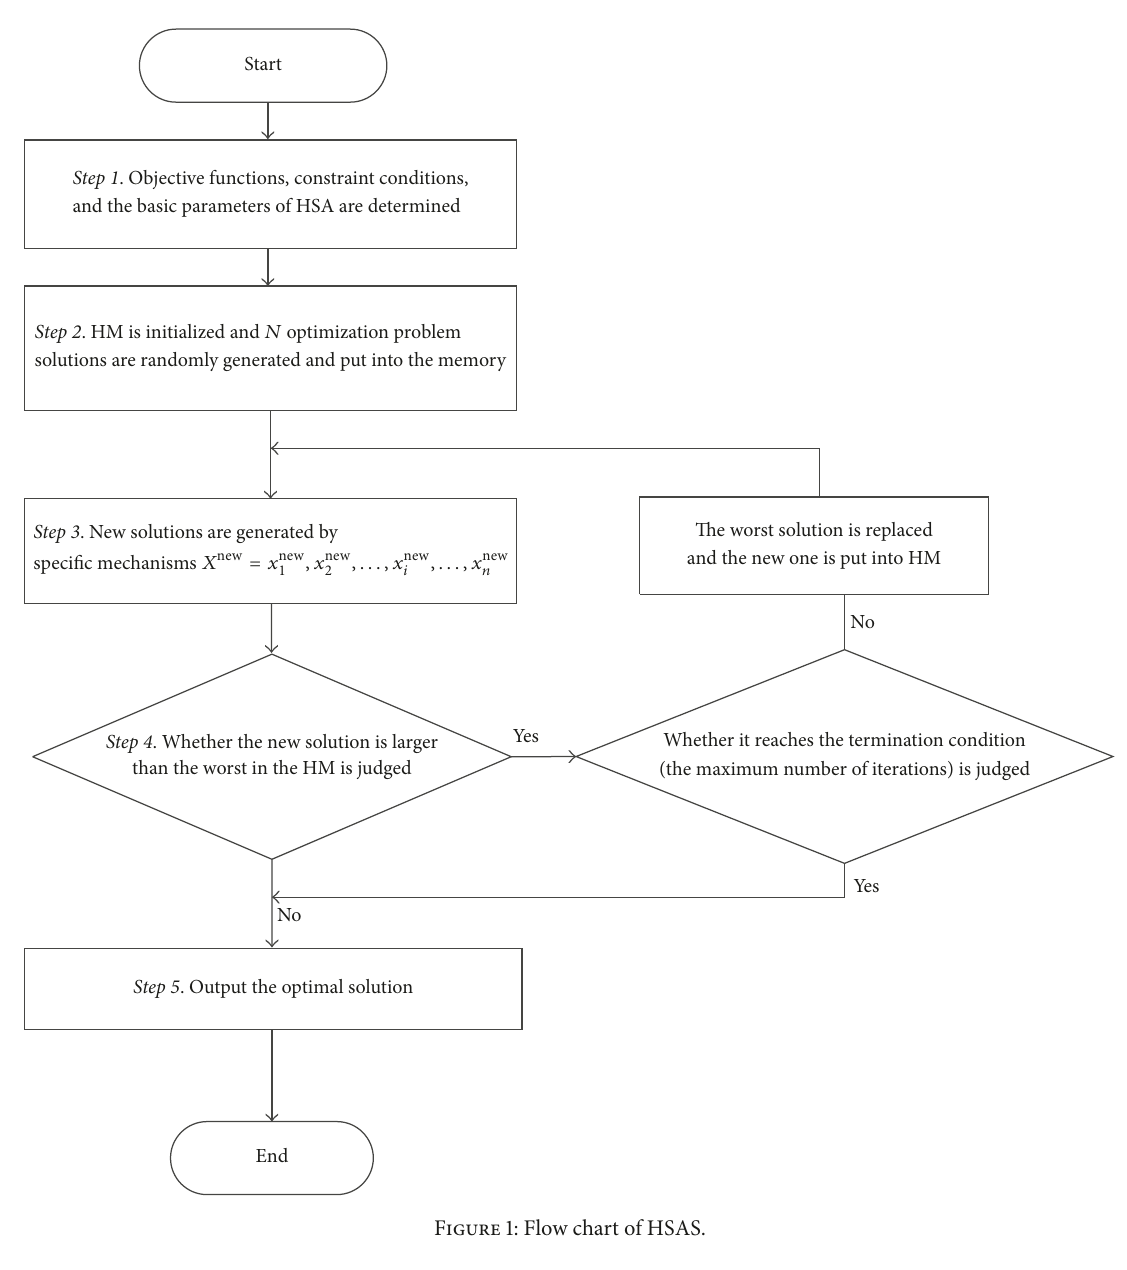
Figure 1: Flow chart of